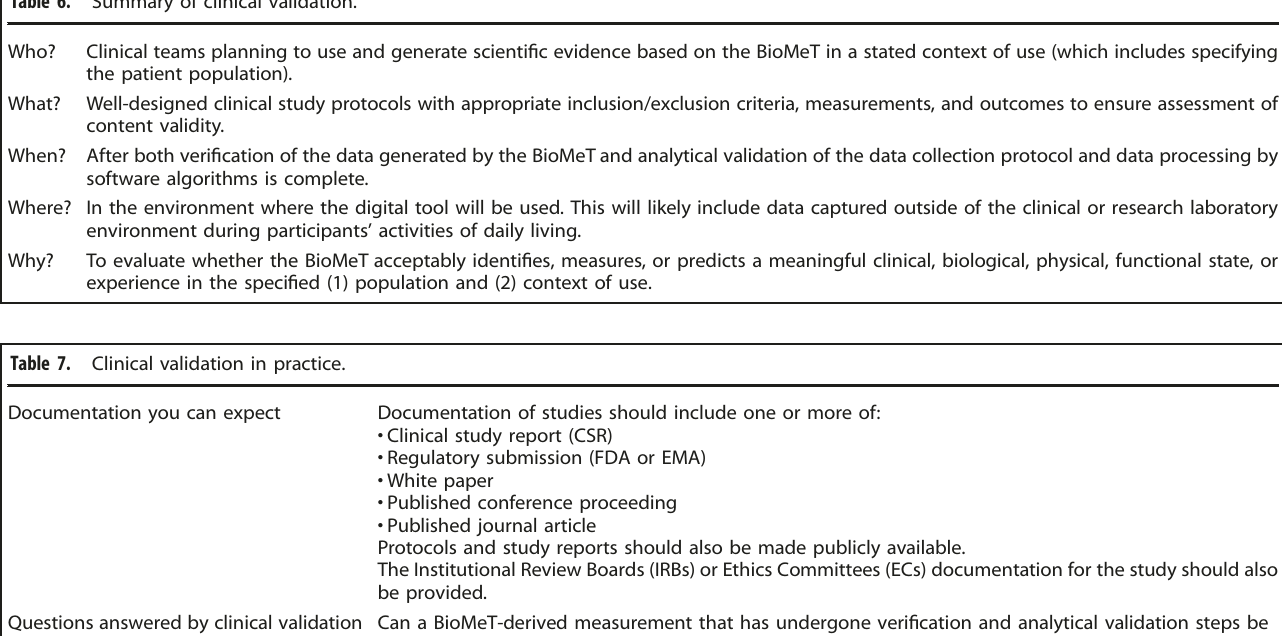
Table 6. Summary of clinical validation. Who?